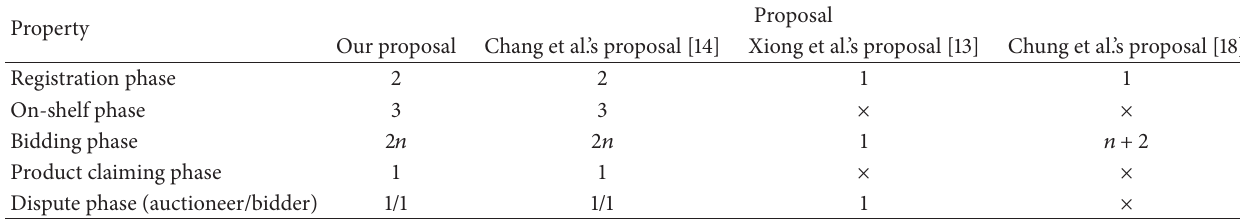
Table 4: Comparison in communication rounds of the three